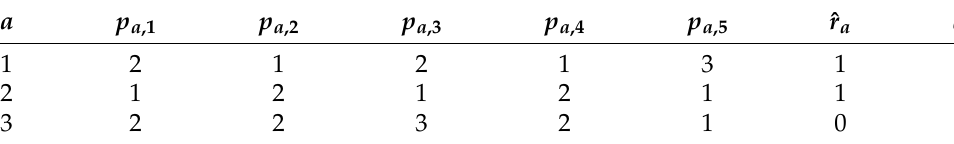
Table 1. Problem instance from Example 1 for n = 5 and m =